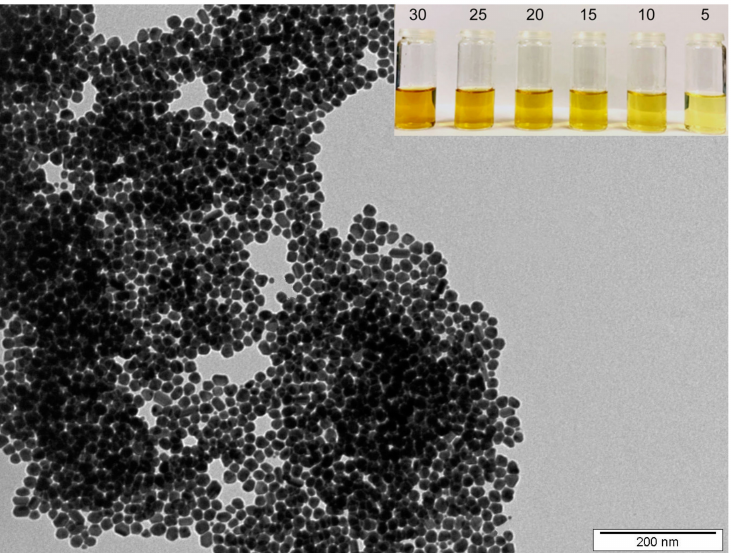
Figure 1. TEM image of as-synthesized silver nanoparticles. Inset shows AgNPs colloids with a decreasing Ag concentration (numbers stand for Ag concentration in mg L − 1 ).